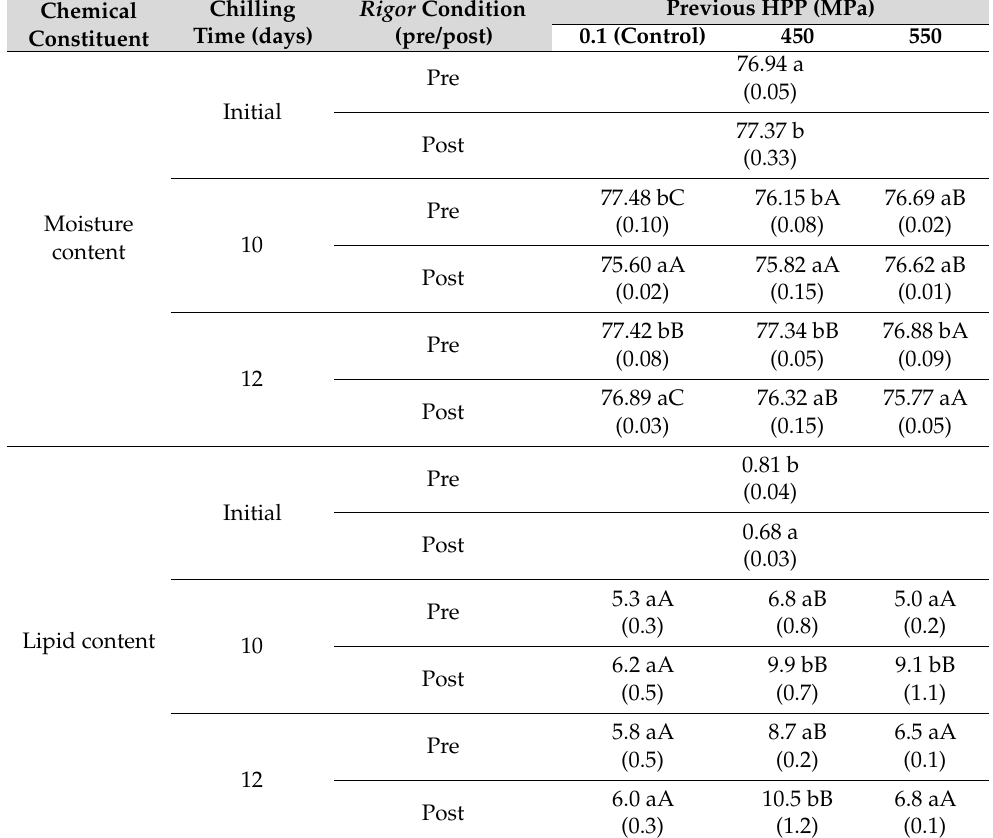
Table 1. Determination (g · 100 g − 1 muscle) * of the moisture and lipid contents in chilled palm ruff corresponding to different initial rigor conditions and previous high-pressure processing (HPP)